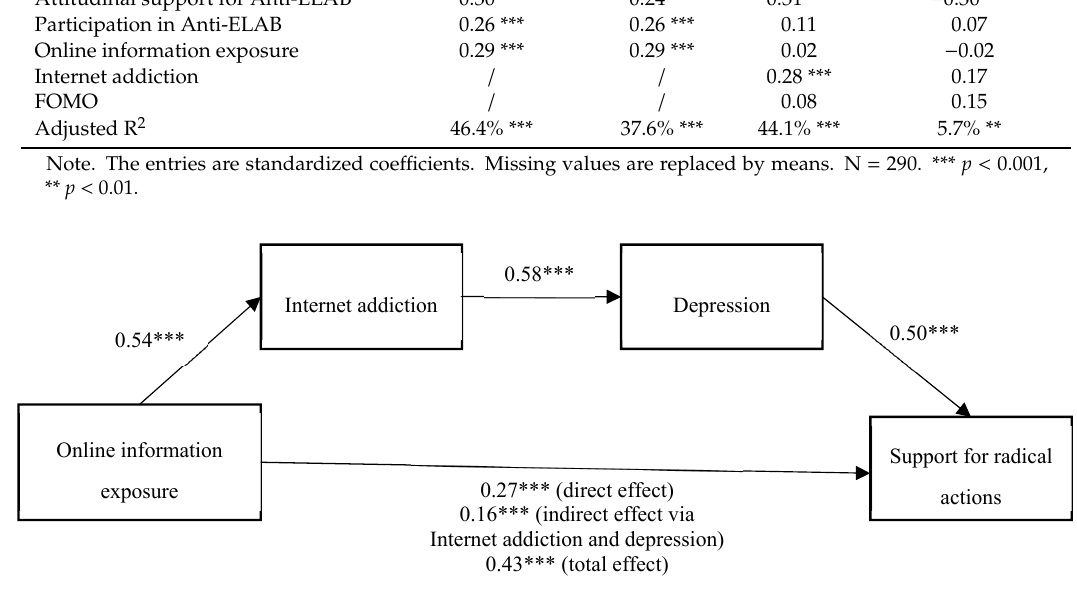
Figure 1. Analysis of mediating e ff ect of Internet addition and depression on online information exposure and support for radical actions. The entries are standardized coe ffi cients. Missing values are replaced by means. N = 290. *** p < 0.001. Gender, age, SES, birthplace, attitudinal support for Anti-ELAB, and participation in Anti-ELAB are included in the analysis, but they are not shown in this figure for simpler demonstration.